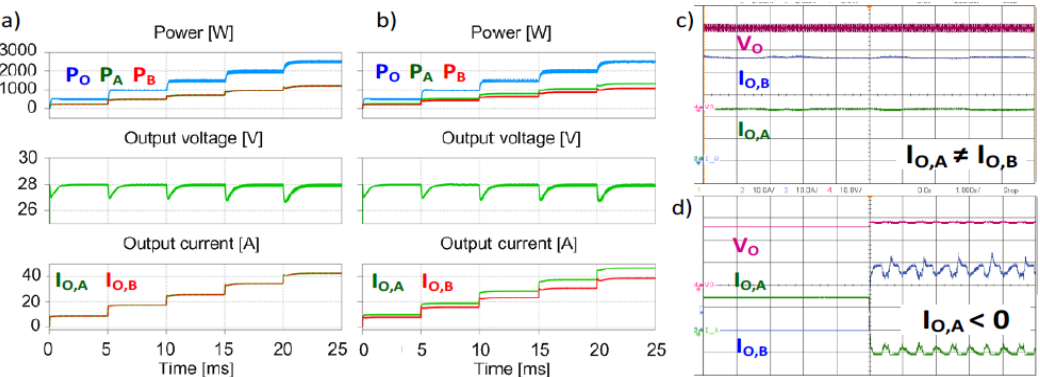
Figure 14. Parallel connection of BDC units without additional control: balanced, ( a ), and unbalanced, ( b ) conditions in simulation; balanced ( c ) and unbalanced ( d ) conditions in experimental tests.